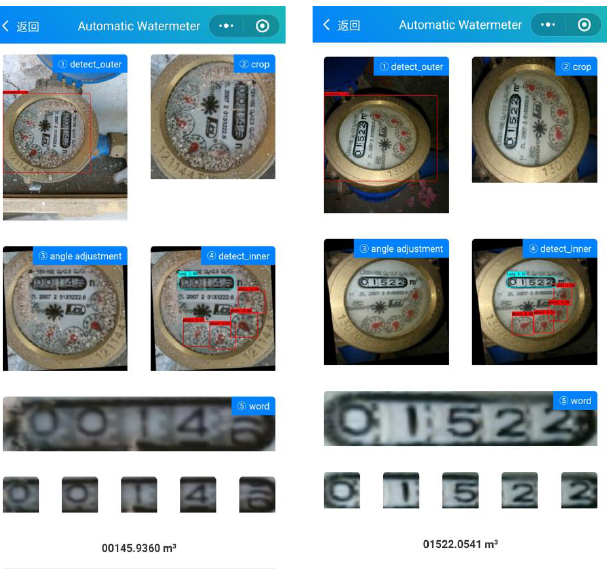
Figure 14. The user interface of the system. Just click to upload the image to complete the meter reading.